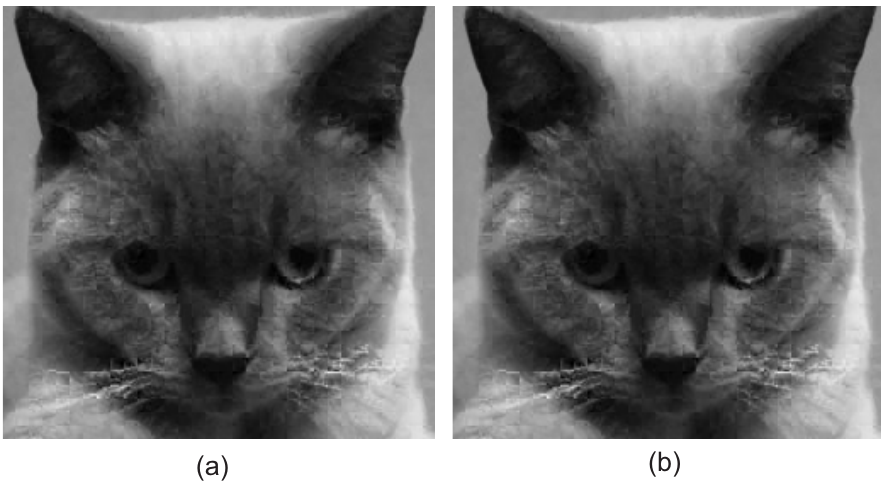
Figure 5. Comparison of Fractal decoded Cat image of size 256 × 256 obtained from the same fractal codebook but with different initial images at the 20th iteration, where the same block size of 8 × 8 is applied in the decoding: ( a ) a zero matrix as an initial image and ( b ) the original Cat image as initial image, where both the decoded images have the same PSNR and SSIM at 26.54 dB and 0.726, respectively.